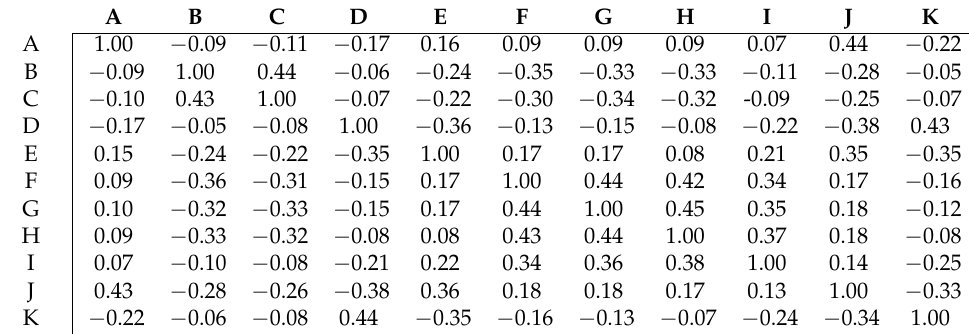
Table 3. Gini correlation between